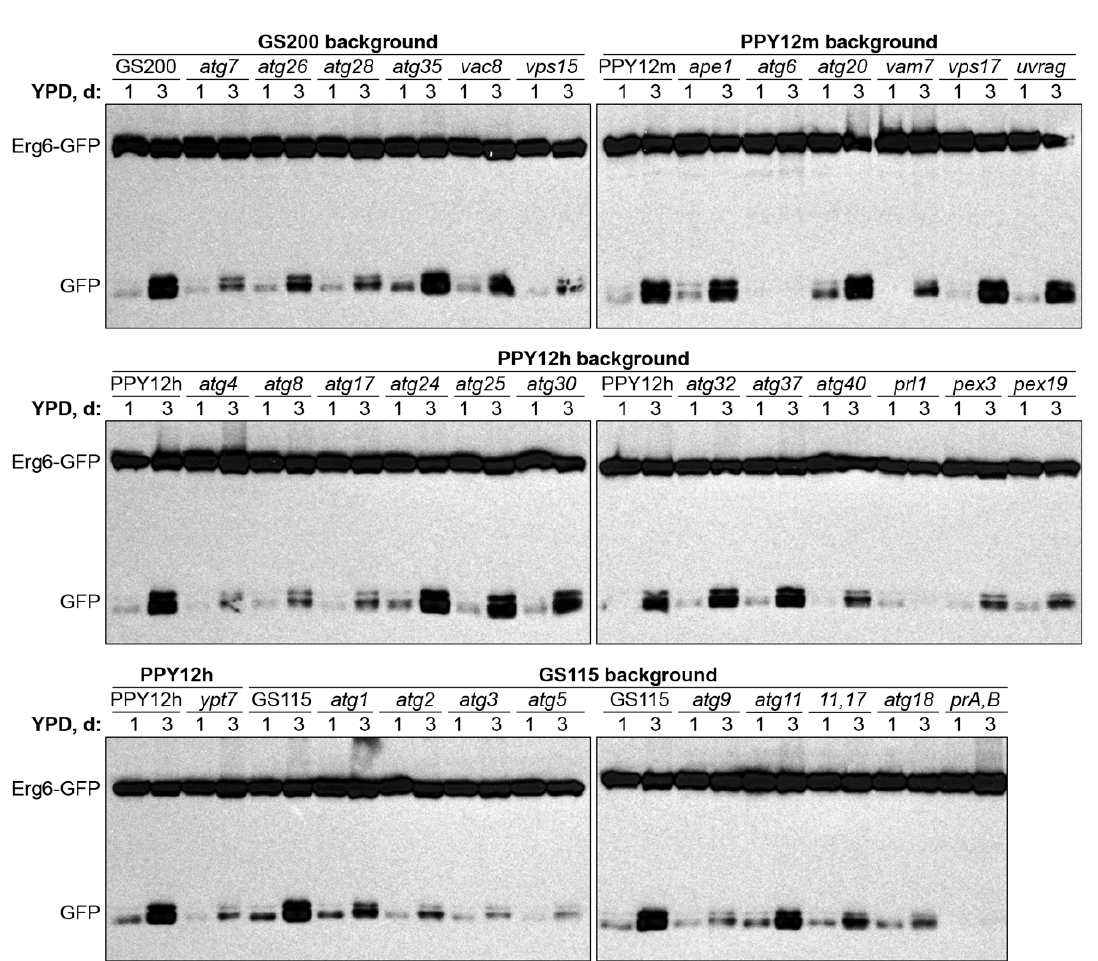
Figure 3. S-phase lipophagy strictly depends only on Atg6, Prl1 (positive regulator of lipophagy 1), and vacuolar proteolysis (proteinases A and B). Since biomass slightly decreased after three days in S-phase, equal biomass (1 OD 600 ) was taken at both time-points for all strains. Ponceau S staining was used as a loading control and displayed in Appendix A Figure A1. prA,B: Proteinases A and B-deficient mutant pep4 prb1 .